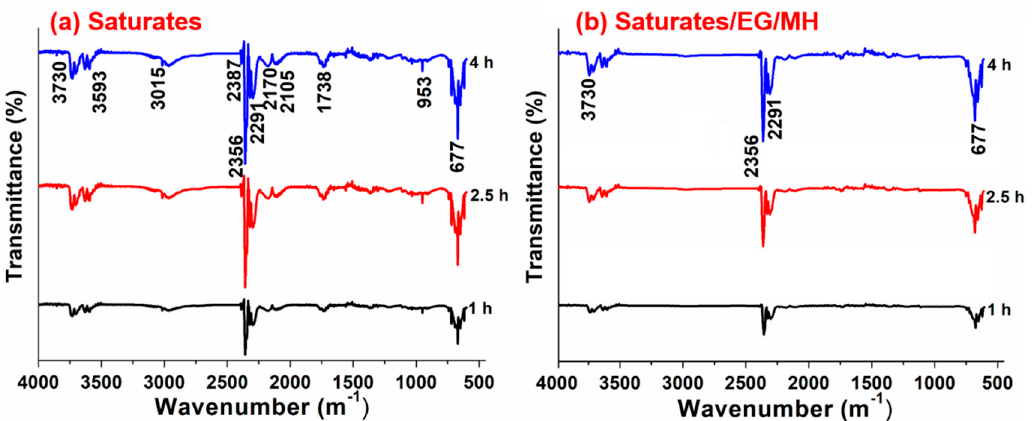
Figure 3. FTIR test results of volatiles released from ( a ) saturates and ( b ) saturates / EG / MH during the isothermal-oxidative